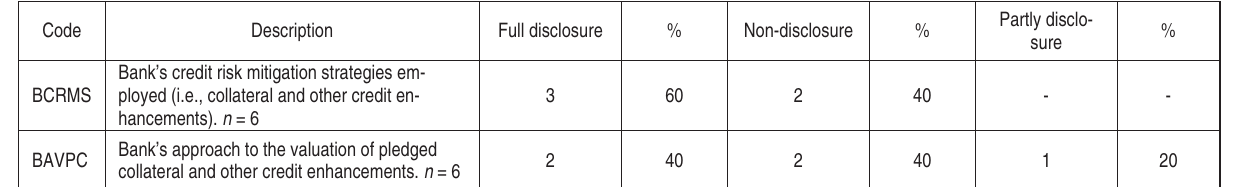
Table 2 (cont.). Consolidated